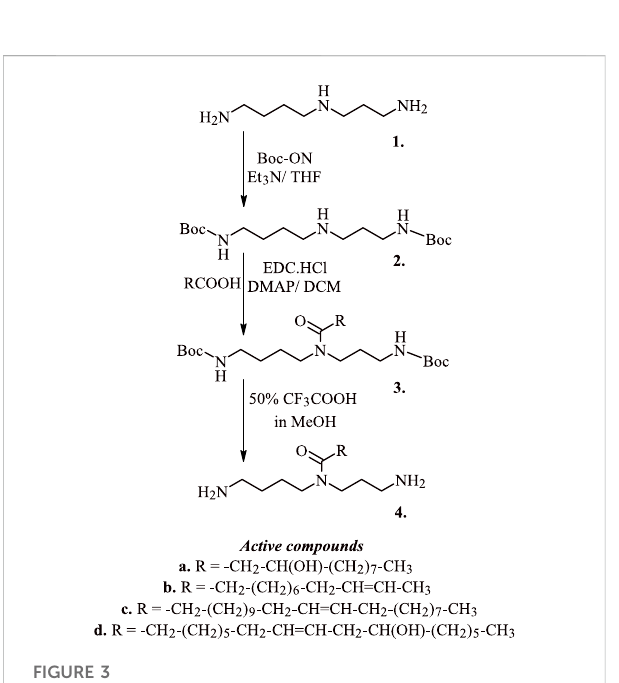
FIGURE 3 Synthesis of active acyl spermidine derivatives that induce apoptosis in cancer cells.